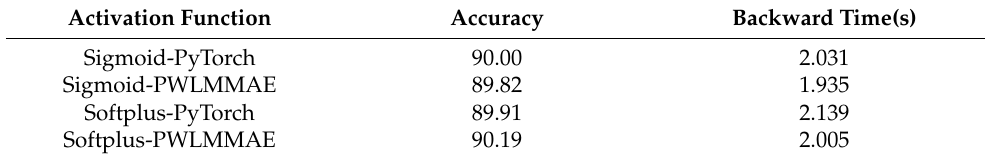
Table 5. Evaluate